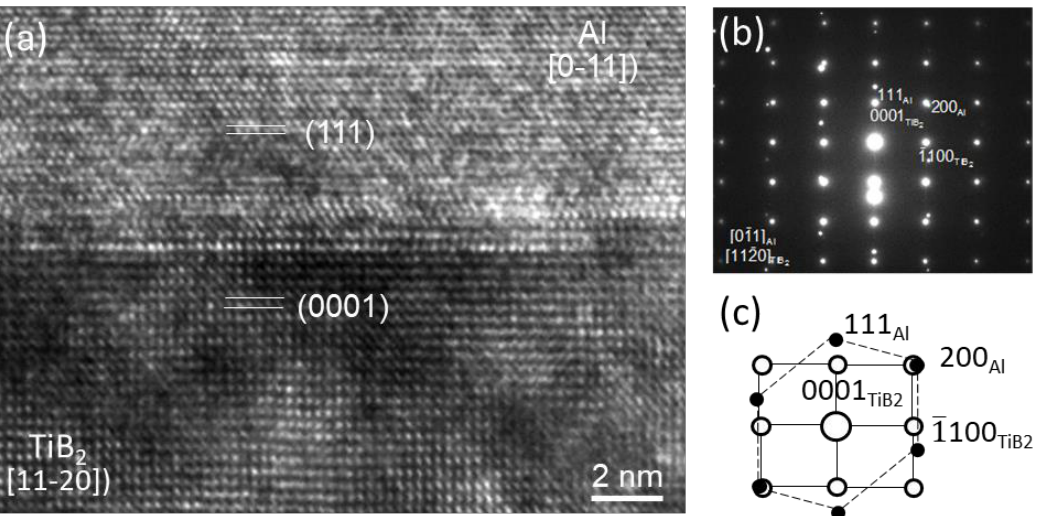
Figure 4. The interface between Al and TiB 2 from Al-5Ti-1B grain refiner [11]. ( a ) HR-TEM image showing the Al/TiB 2 interface viewed in the direction of [1 1 2̅ 0]TiB 2 and [0 1̅ 1]Al; ( b ) selected area electron diffraction (SAED) pattern taken from TiB 2 and Al across the interface; and ( c ) the indexed pattern of ( b ). The orientation relationship (OR) between TiB 2 and Al is: (0 0 0 1)[1 1 2 0] TiB 2 // (1 1 1)[0 1